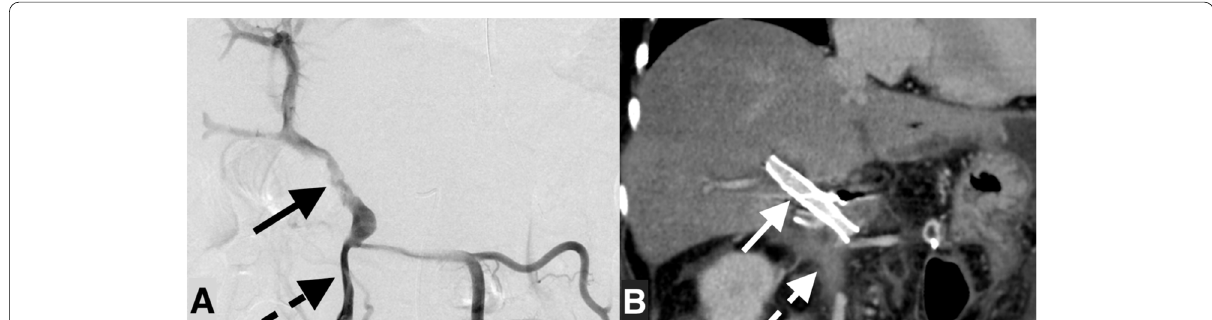
Fig. 2 A patient with residual stenosis (outside-stent) which resulted in stent occlusion. A man in his 60 s presented with melena two months after subtotal stomach-preserving pancreatoduodenectomy for ampullary cancer. The contrast enhancement of the portal vein (PV) to superior mesenteric vein (SMV) was unclear and considered to be an occlusion or severe stenosis. Late-onset pancreatic juice leakage was considered as a cause. PV stent placement and total pancreatectomy (to control pancreatic juice leakage) was planned emergently. A Portography shows PV stenosis (arrow). Two stents (SMART Control; Cordis, Hialeah, FL, USA) were placed through the PV and post-stent balloon dilatation was performed up to the nominal pressure. Stent placement was not performed for SMV because it was unrecognized (dotted arrow). After the stent placement, PV flow improved. Subsequently, residual total pancreatectomy was performed. B Contrast-enhanced CT six days after the stent placement (arrow). The contrast enhancement of the SMV on the caudal side of the stent is unclear (dotted arrow). Two years and three months after placement, the stent